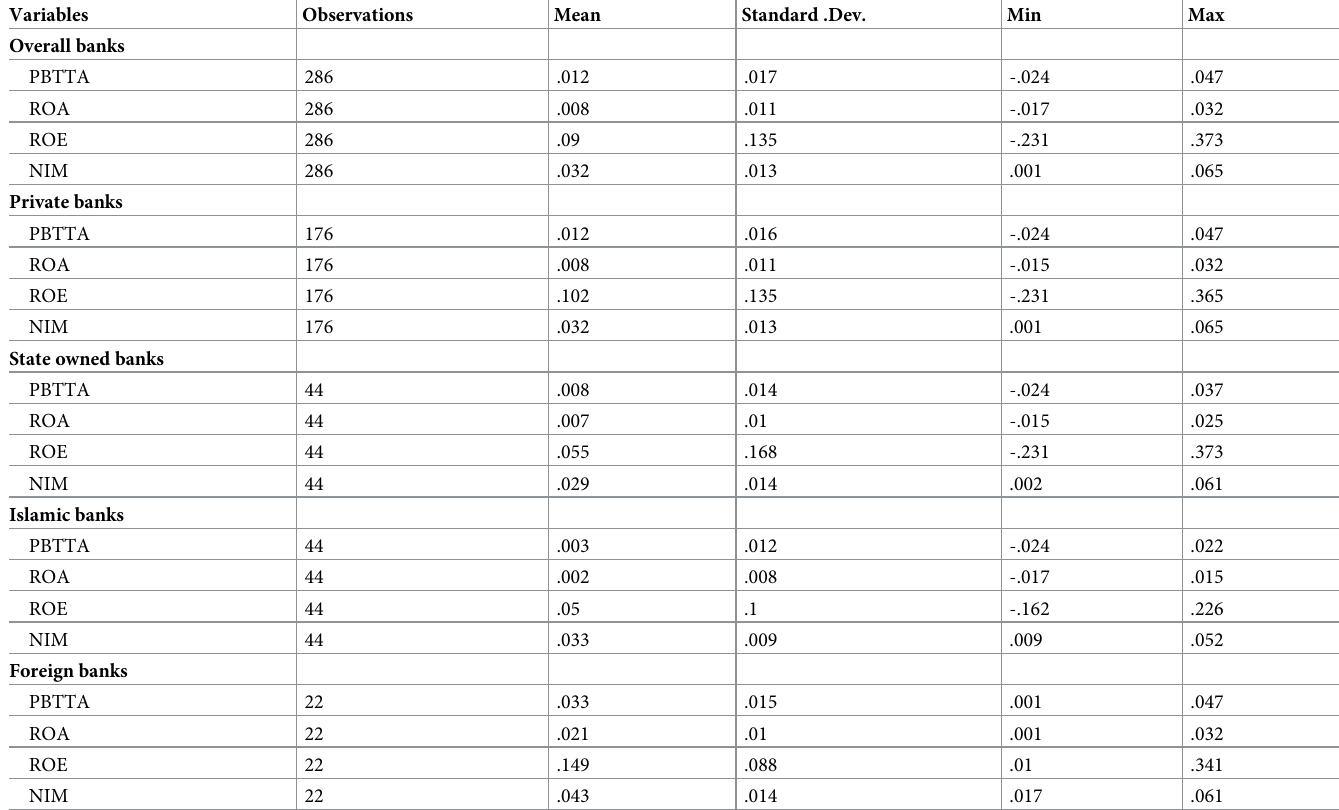
Table 3. Summary of profitability